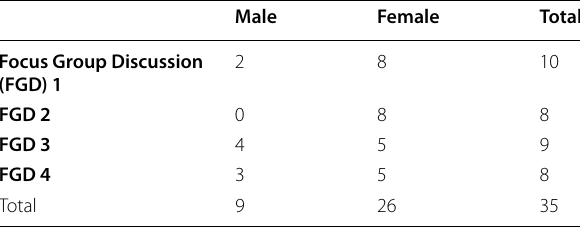
Table 4 Demographics of focus group participants ( N